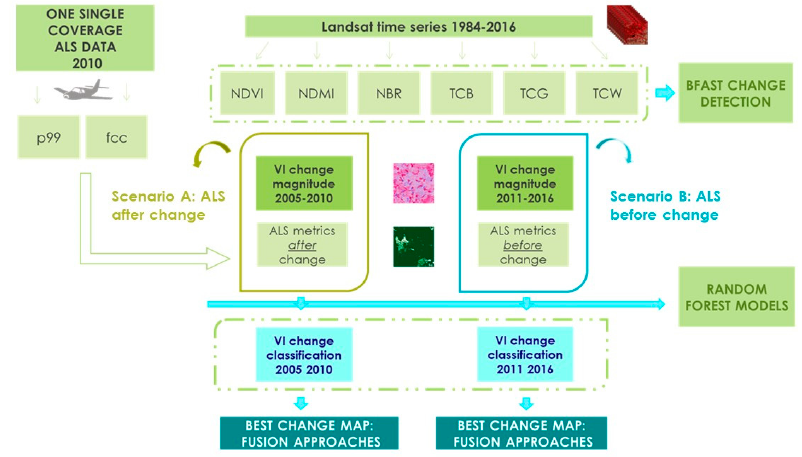
Figure 4. General methodology workflow applied for classification of changes related to forest harvesting practices in scenario A and scenario B .